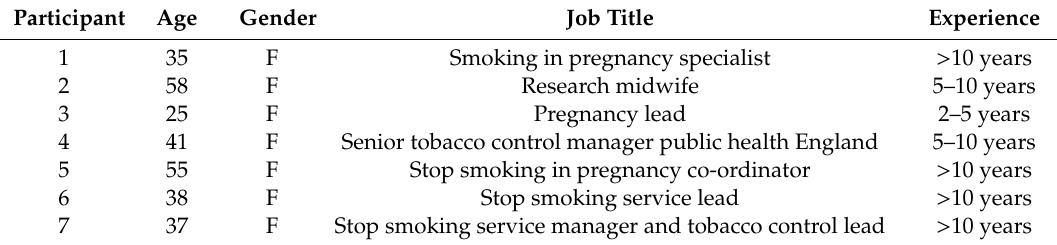
Table 2. Characteristics of expert group